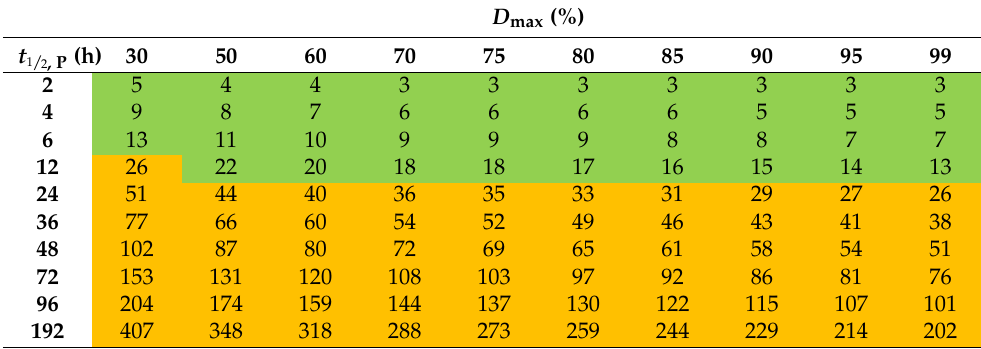
≤ x ). A 2 ,P . 2 ,P D max (%)